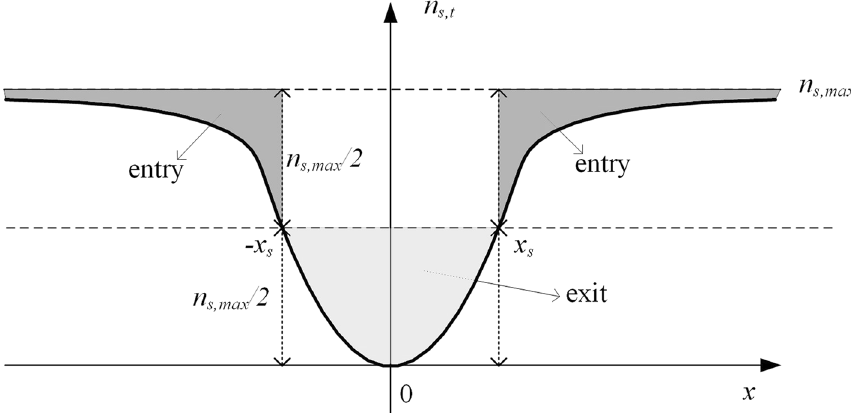
Fig. 2 Fraction of stabilizers n s , t varies with the deviation x . n s , max is the limited maximum fraction of stabilizers in the market and x s is the threshold for stabilizers. When | x | is greater than x s , stabilizers enter the market; when | x | is smaller than x s , stabilizers exit the